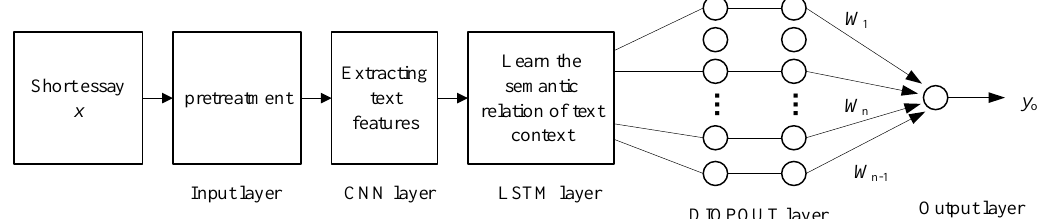
Figure 1. CNN-LSTM model structure .